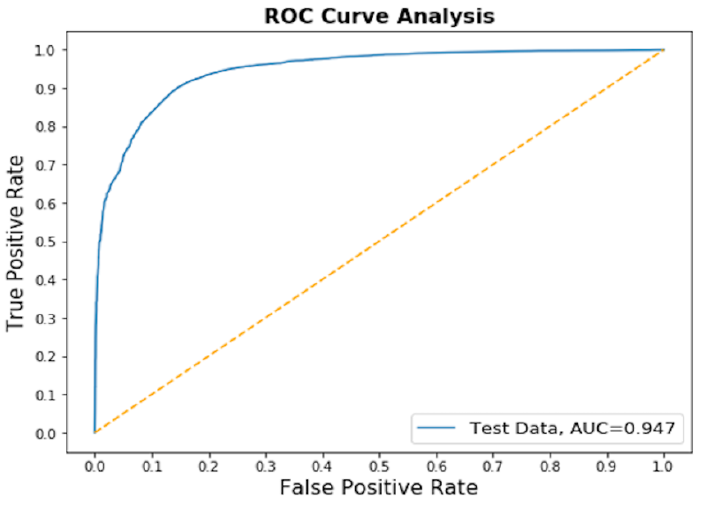
Figure 8. The ROC of the